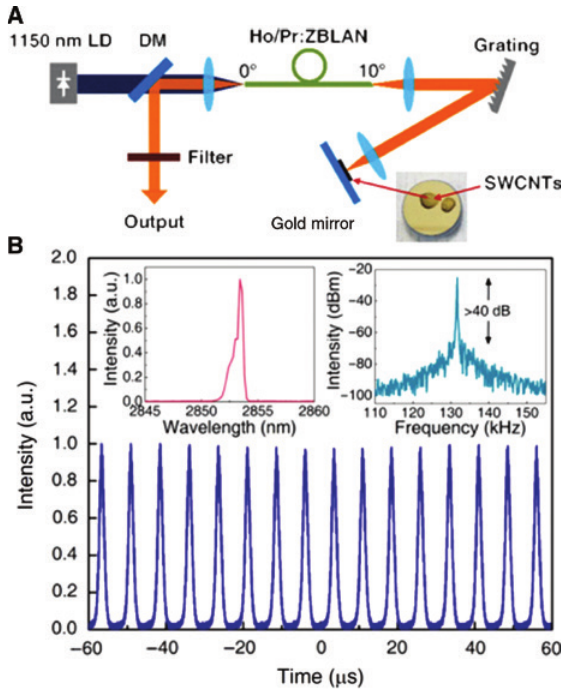
Figure 10: Schematic setup and output pulse train. (A) Schematic setup of the CNT SA Q-switched Ho,Pr:ZBLAN laser and (B) the output pulse train, left inset: the corresponding spectrum at 2853 nm; right inset: the corresponding radio- frequency (RF) spectrum with a signal-to-noise ratio of 40 dBc. Lü et al. [54] © Chinese Laser Press 2019.